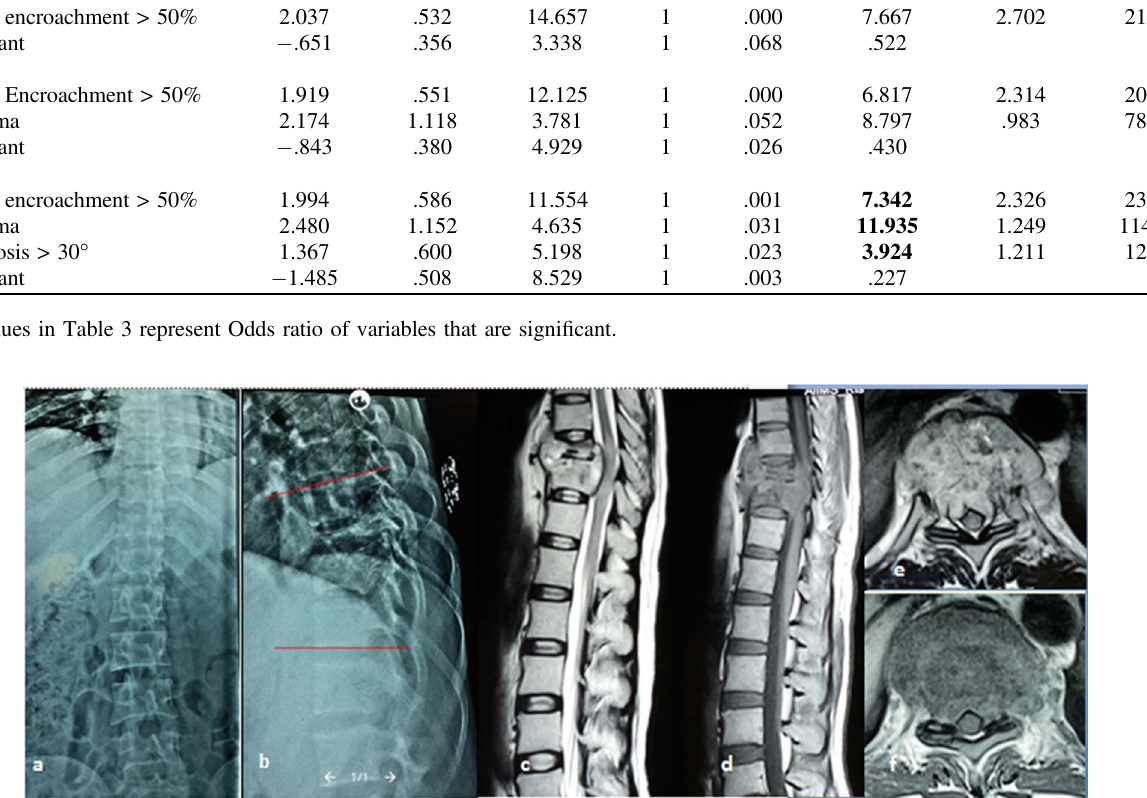
Figure 5. A 42-year-old female diagnosed as case of Potts spine D9 – D10 with neurological de fi cit. (a) X-ray AP and (b) lateral view showing fuzziness of end plates of D9 – D10 with kyphosis of 16 (cid:1) measured using cobs method. (c) MRI sagittal T2WI, (d) sagittal T1WI, (e) axial T2WI, (f) axial T1WI showing paradiscal involvement of D9 – D10 vertebral bodies with endplate destruction and altered marrow signal intensity, prevertebral and epidural collection causing loss of anterior CSF around cord and cord compression.